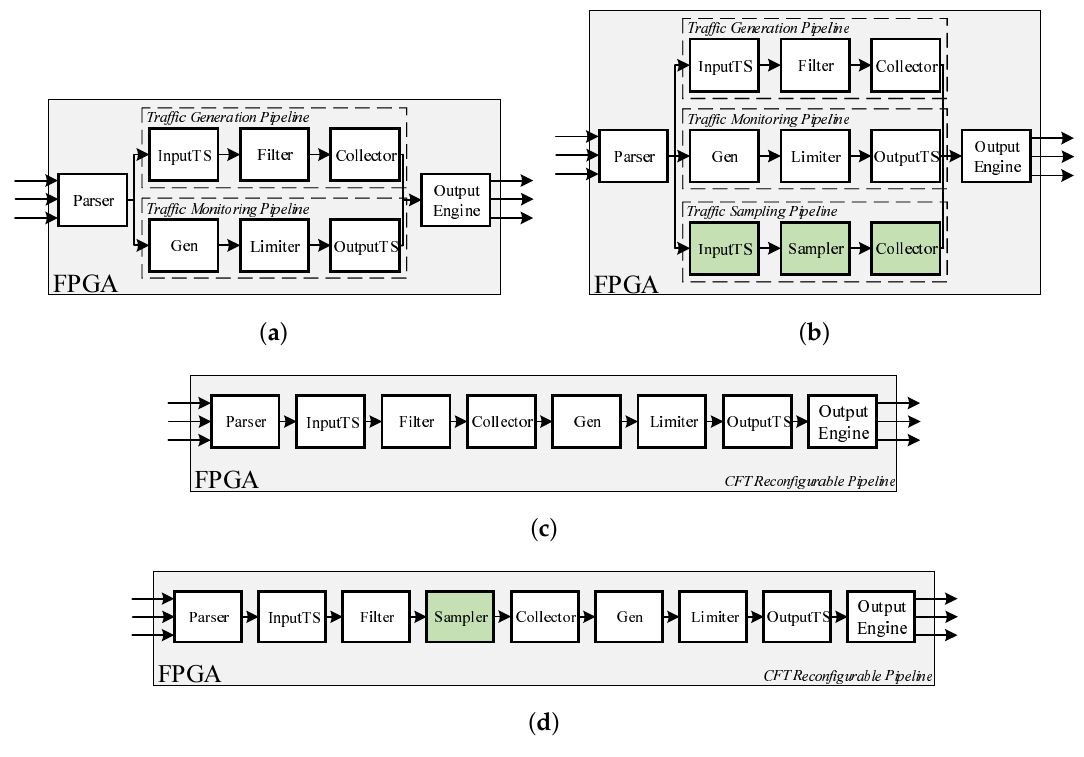
Figure 7. The differences in the pipeline extension; ( a ) the pipeline of existing tools, ( b ) the extension pipeline of existing tools, ( c ) the pipeline of CFT, ( d ) the extension pipeline of